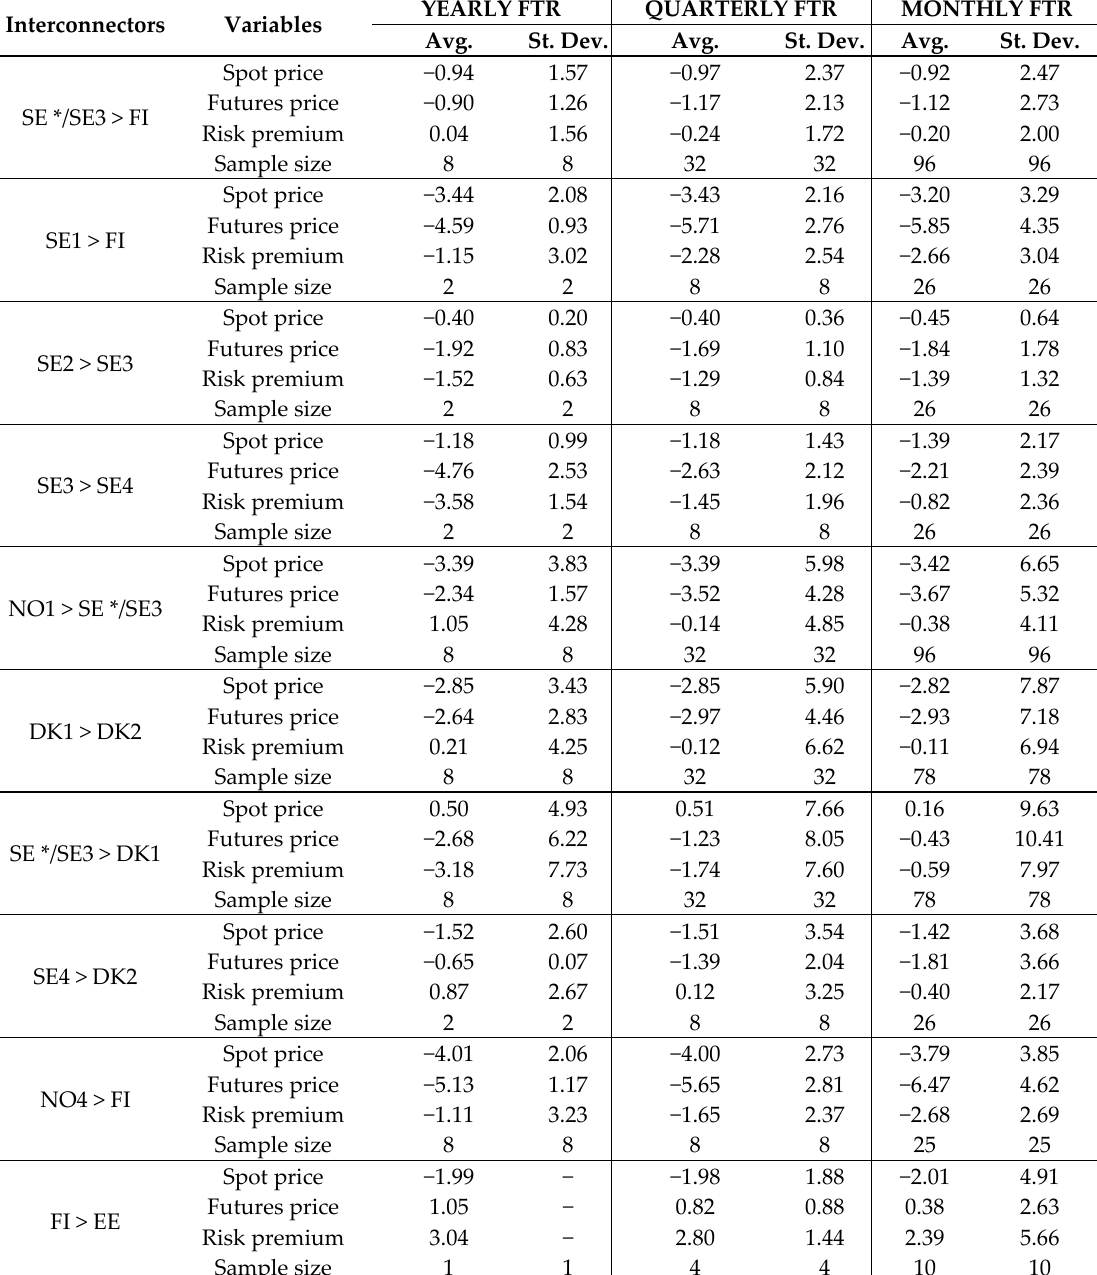
Table 4. Average spot price, futures price, and risk premium for the theoretical FTRs during 2006–2013.